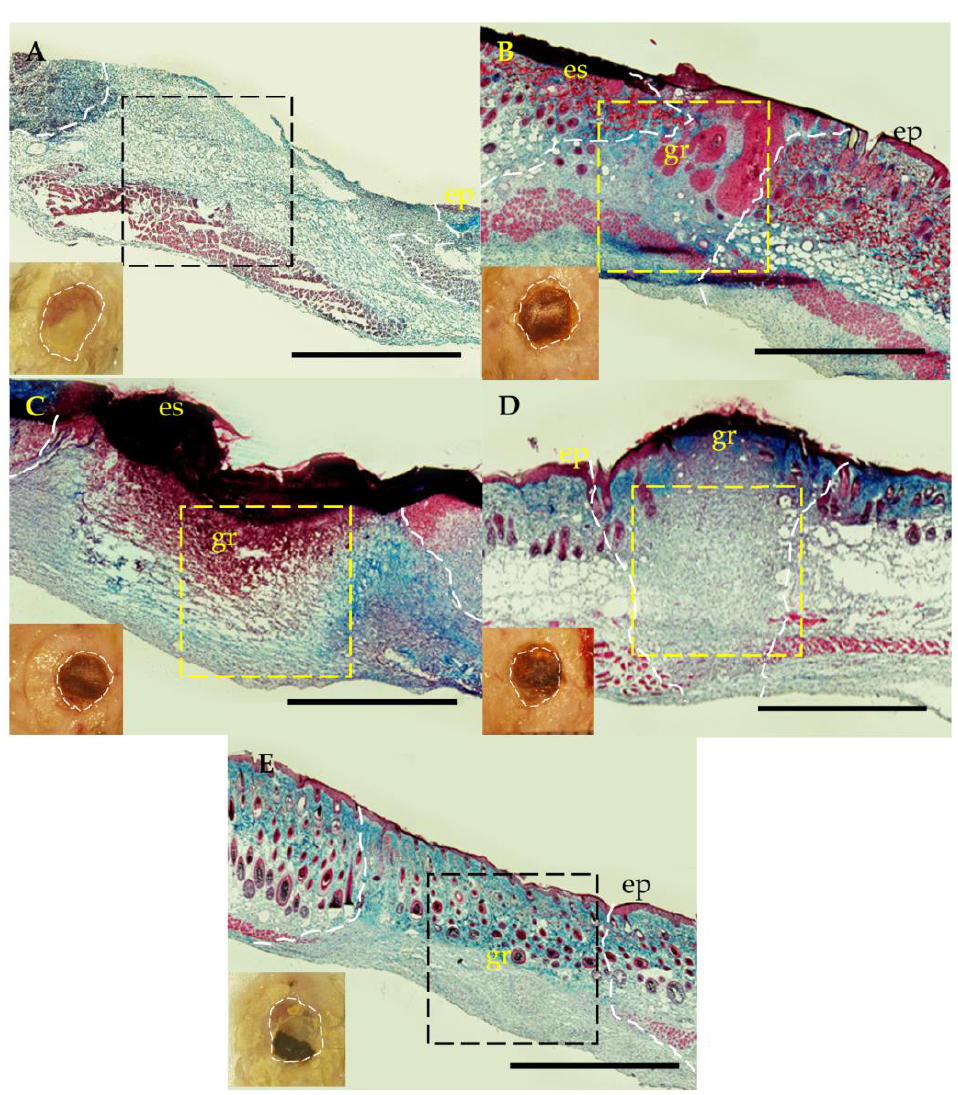
Figure 7. Representative trichrome histological image of the harvested tissue on day 7 after treatment with control ( A ), PEG-D4-Si ( B ), PEG-D6-Si ( C ), PEG-D8-Si ( D ), and PEG-D6 ( E ). Black ( A , E ) and yellow ( B – D ) dash lines indicate the area used to calculate collagen content. White dash line indicates the wound proximities. es = eschar, gr = granulation tissue, and ep = epidermis. Scale bars are 1 mm.